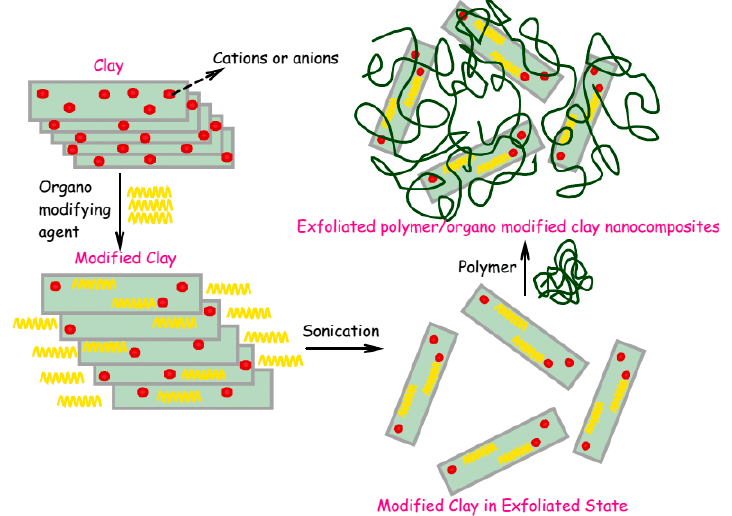
Figure 12. Schematic representation for the preparation of exfoliated polymer/organomodified